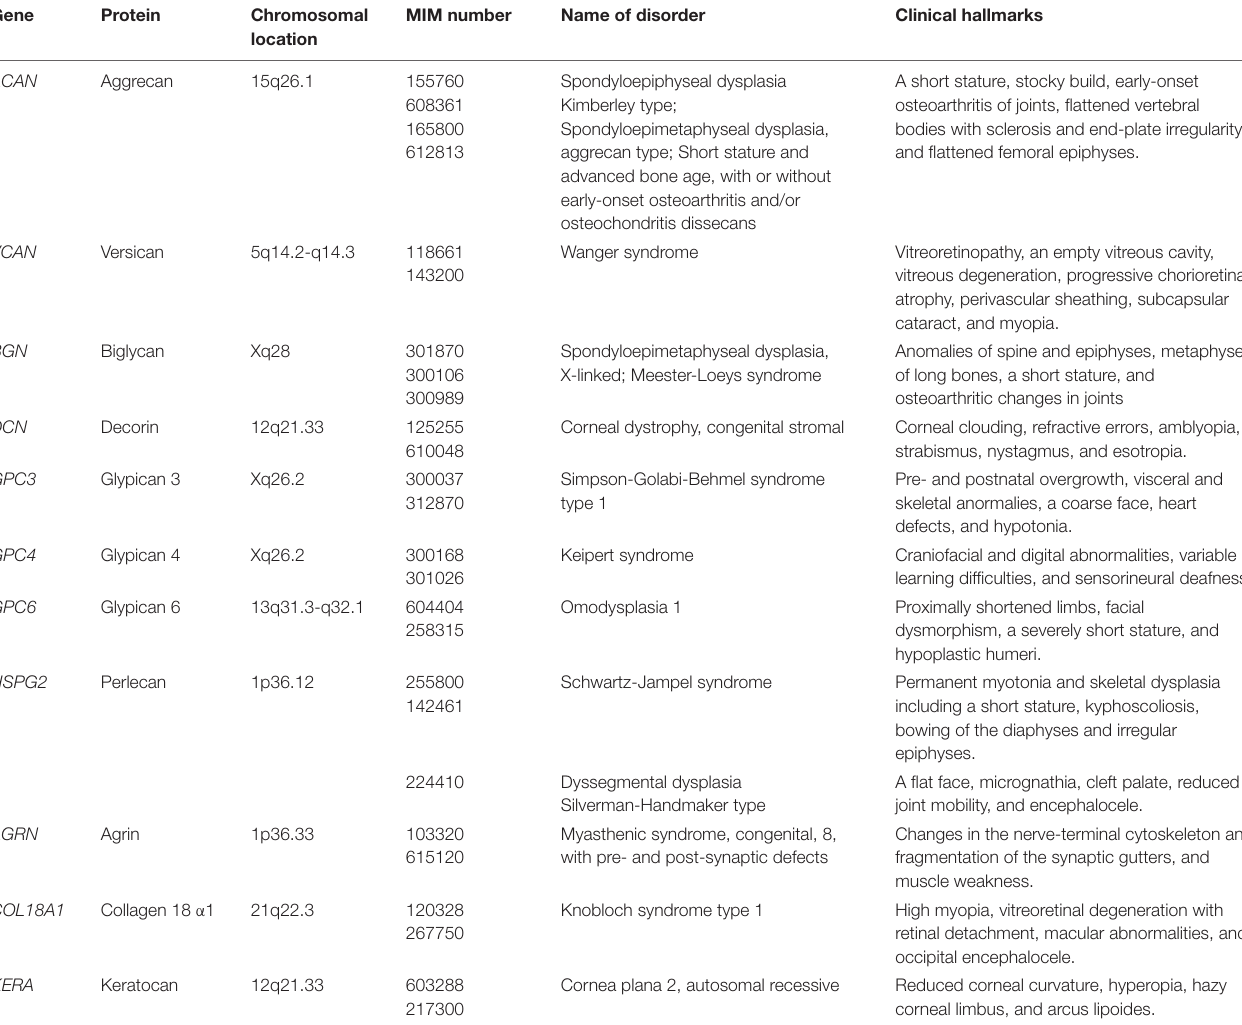
TABLE 6 | Congenital disorders of core proteins of